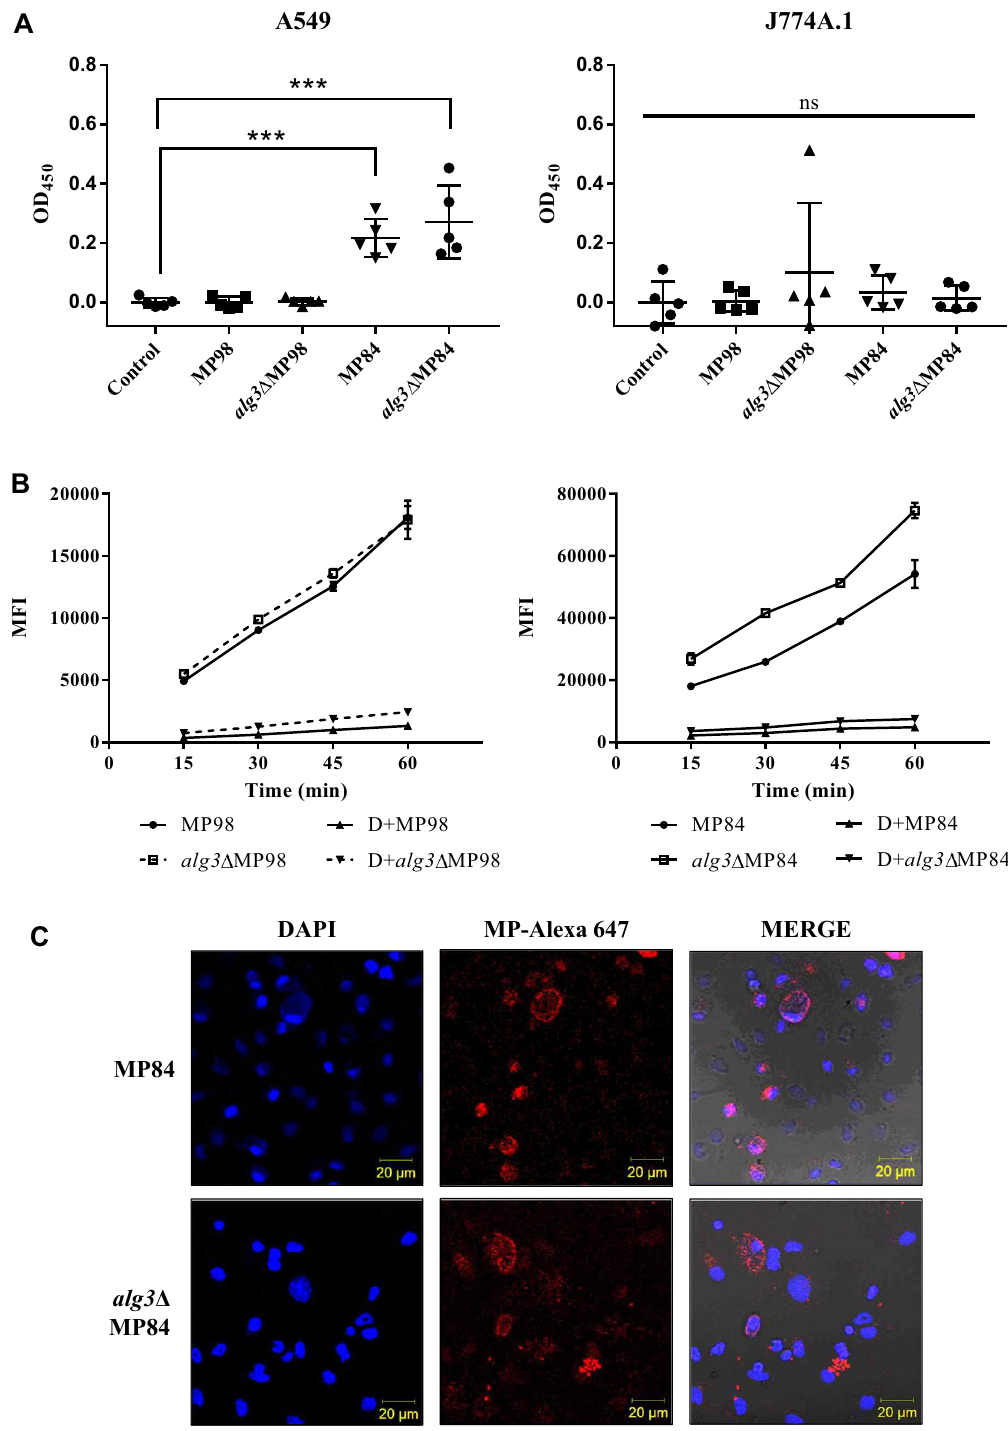
Figure 3. Analysis of cellular adhesion and uptake of MP98 and MP84. ( A ) Adhesion to lung epithelial A594 cells and J774A.1 macrophages. MPs were incubated with mammalian cells for 80 min and analyzed through ELISA. Control is only host cells without incubation with MPs. Significant differences were obtained via one-way ANOVA (*** P ≤ 0.001, ns P > 0.05). ( B ) Kinetics of the uptake of mannoproteins by BMDCs. MPs (20 μg/ml) labeled with Alexa fluor 647 were incubated with differentiated BMDCs for 15-, 30-, 45-, and 60-min. PBS was used as a negative control. Methyl-α-d-mannopyranoside (+D) was used as a competitive inhibitor of the mannose receptor. The uptake of labeled MPs was analyzed using an Attune NxT flow cytometer with acoustic-assisted hydrodynamic focusing (ThermoFisher) and expressed as the fluorescence geometric mean from an electronically gated live cell population. MFI, mean fluorescence intensity. ( C ) Confocal microscopy analysis of MP uptake by BMDCs. MPs labeled with Alexa fluor 647 dye were incubated with BMDCs for 24 h. The nucleus of BMDCs was stained with 1X DAPI for 1 min and verified through laser scanning confocal microscopy (Carl